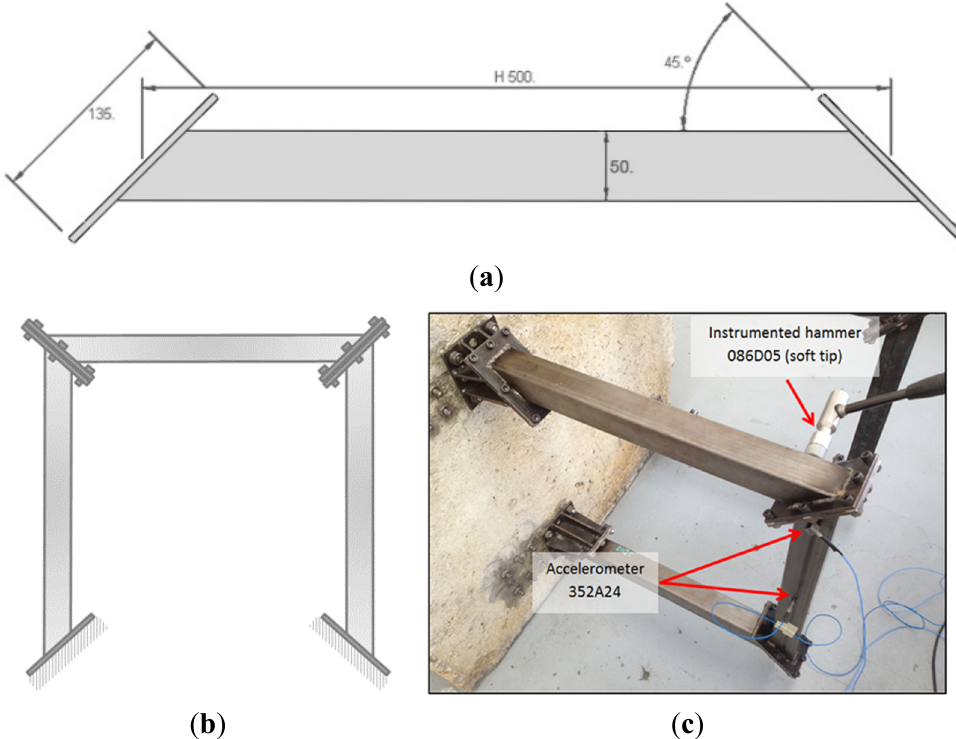
Figure 1. ( a ) Dimensions of steel tube; ( b ) Schematic representation of the model of portal composed by three samples; ( c ) Experimental setup for the frequency response functions (FRF) estimation along with accelerometer and impact point